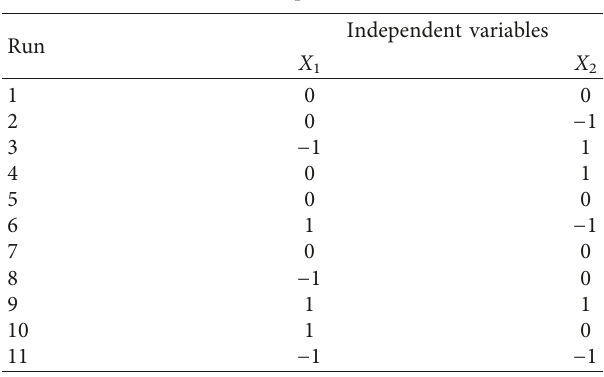
Table 4: Analysis of variance (ANOVA) for ammonia oxidation